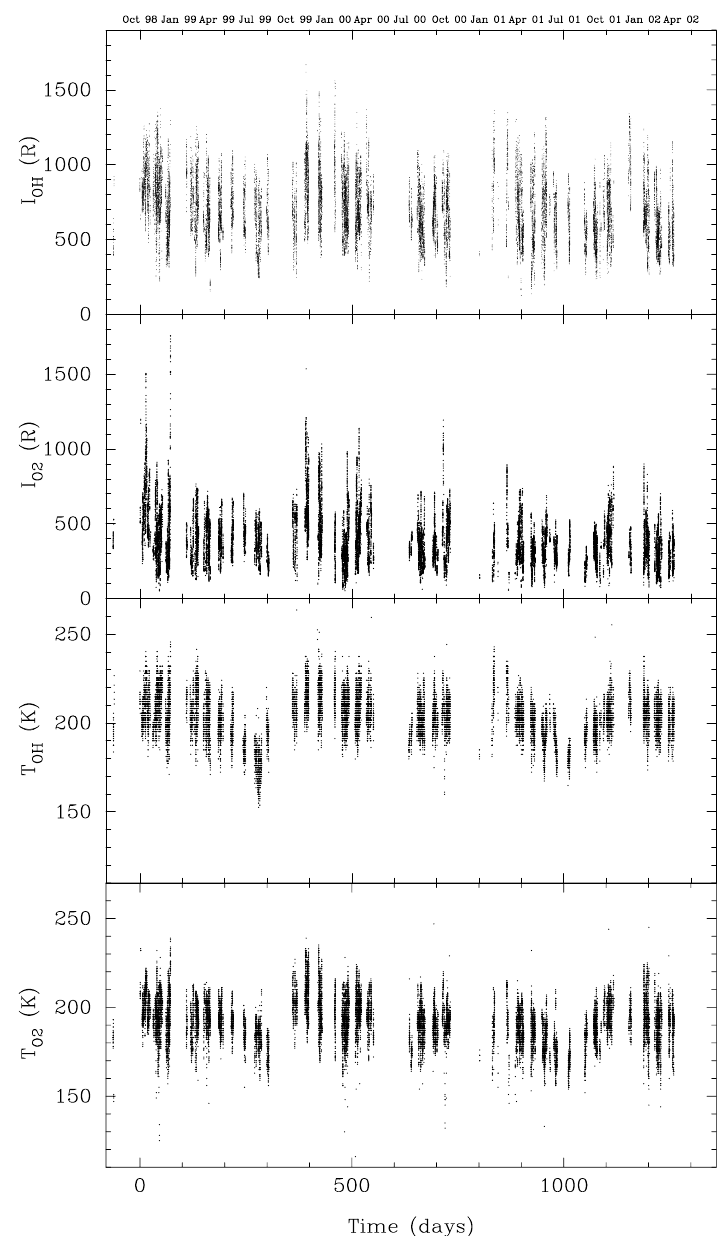
Fig. 2. Rotational temperatures and emission